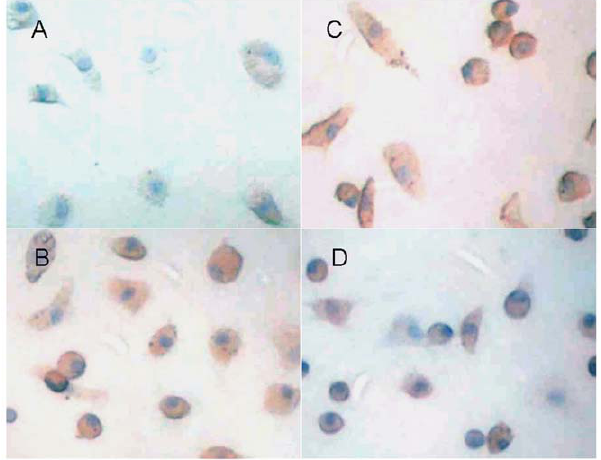
Figure 2. Immunostaining of spleen-derived EPCs. 7 days after in vitro differentiation, spleen-derived EPCs showed expression of CD31 (B), CD34 (C) and vWF (D) with the cytoplasm stained in brown. Photo A is the control. Hematoxylin-stained nuclei were shown in blue. (Magnification 6 400).